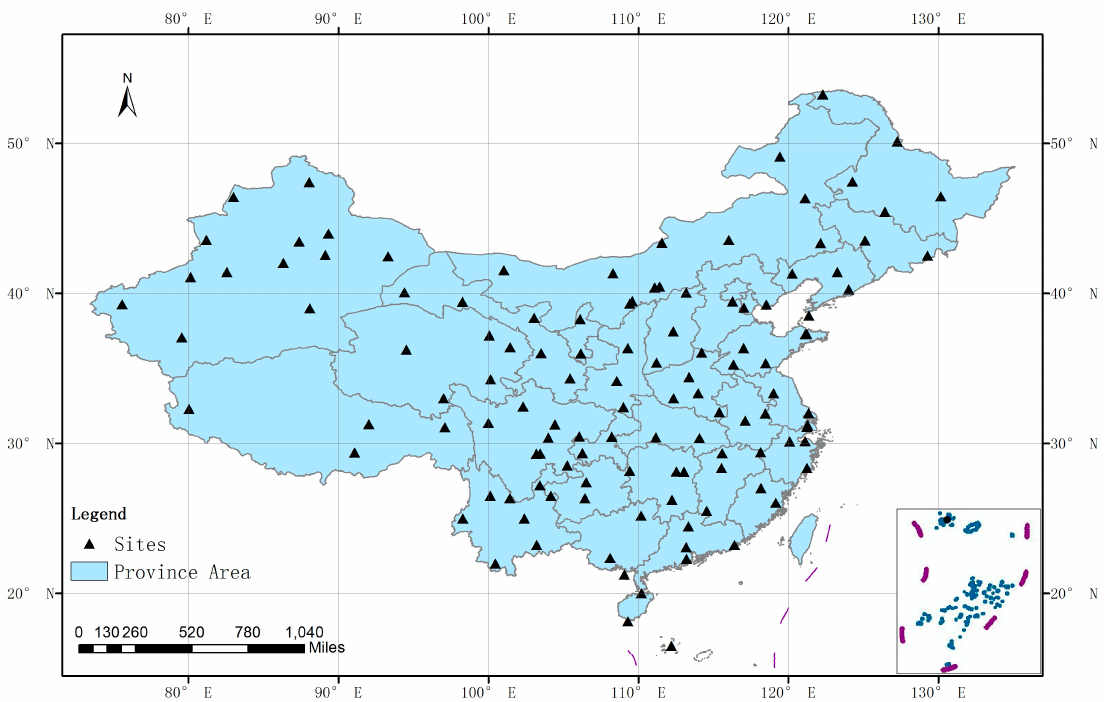
Figure 1. Spatial distribution of the radiation sites provided by the China Meteorological Administration (CMA) Meteorological Information Center.